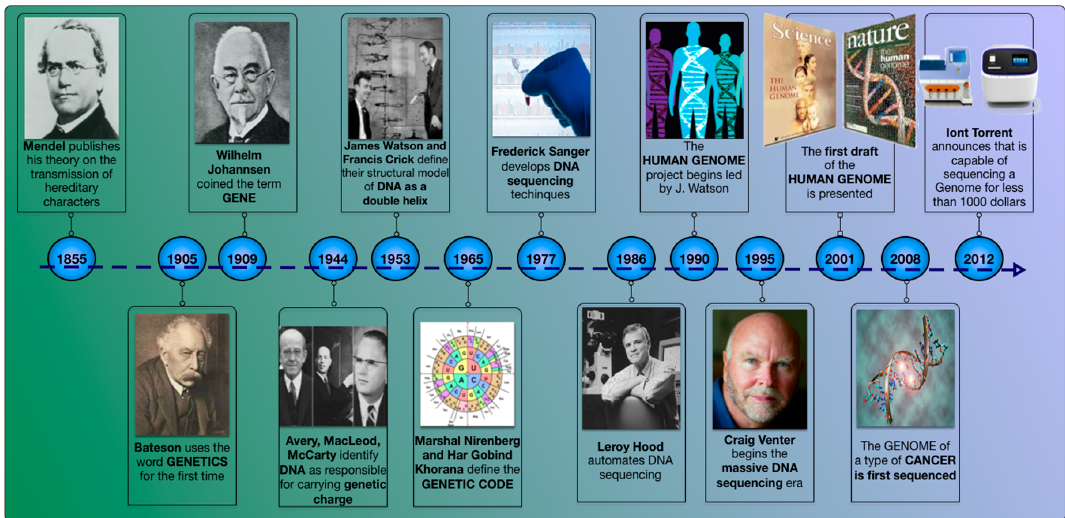
Figure 1. The timeline of DNA sequencing.